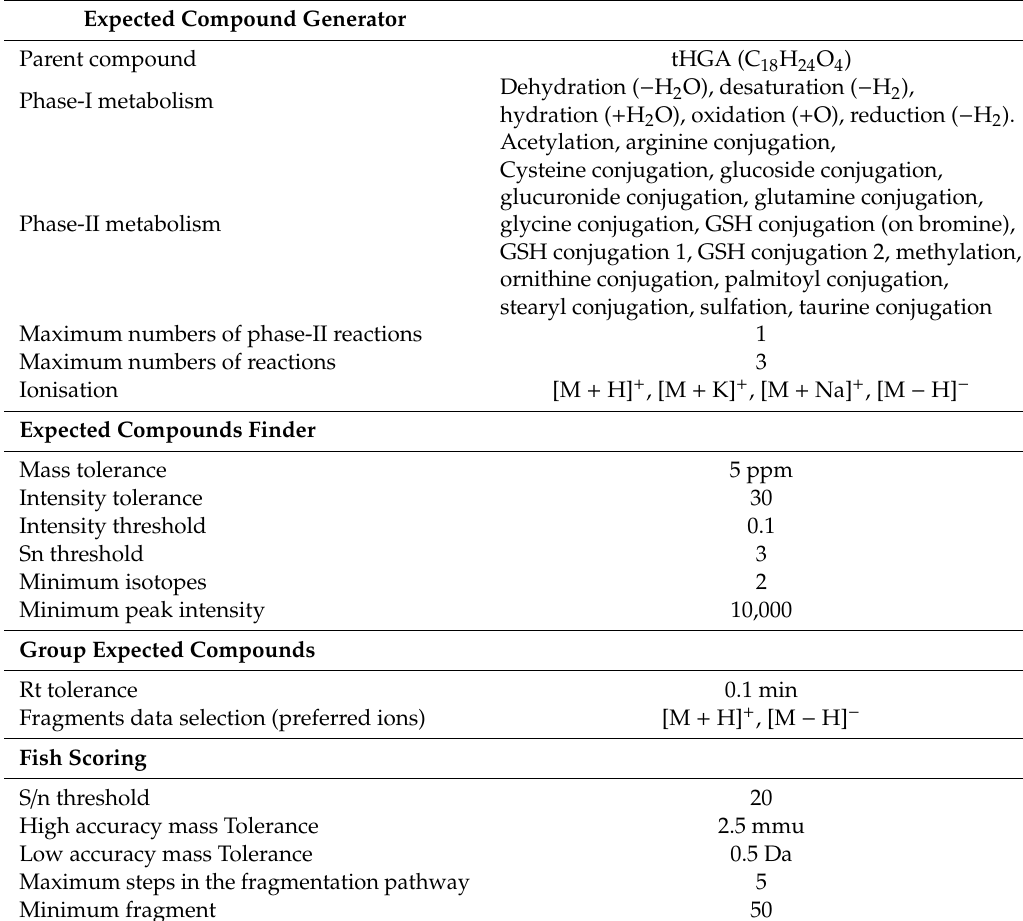
Table 5. Compound discoverer software